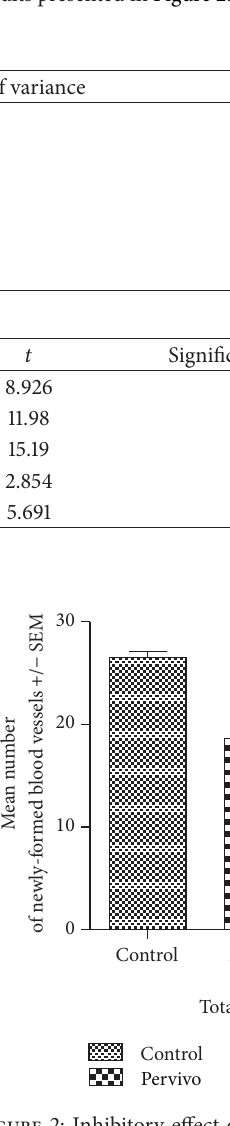
Table 2: Statistical analysis of the results presented in Figure 2.